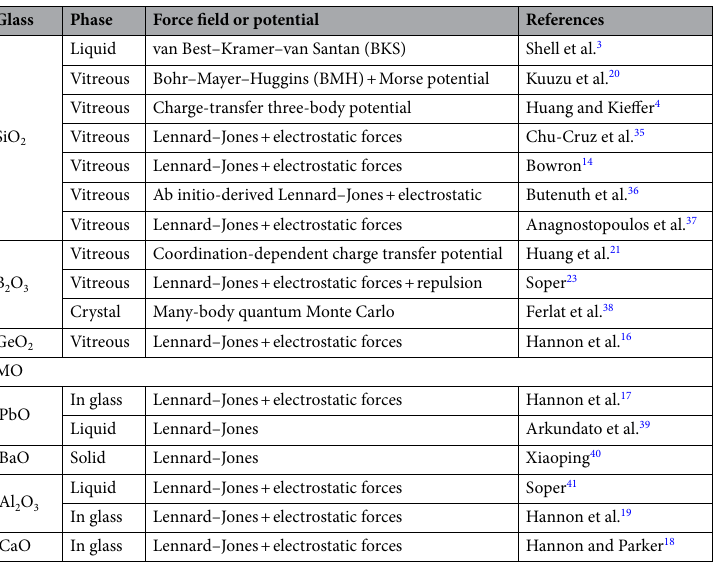
Table 1. Force fields/potentials that have been used to model various pure glasses and metal oxides. MO Metal oxide.